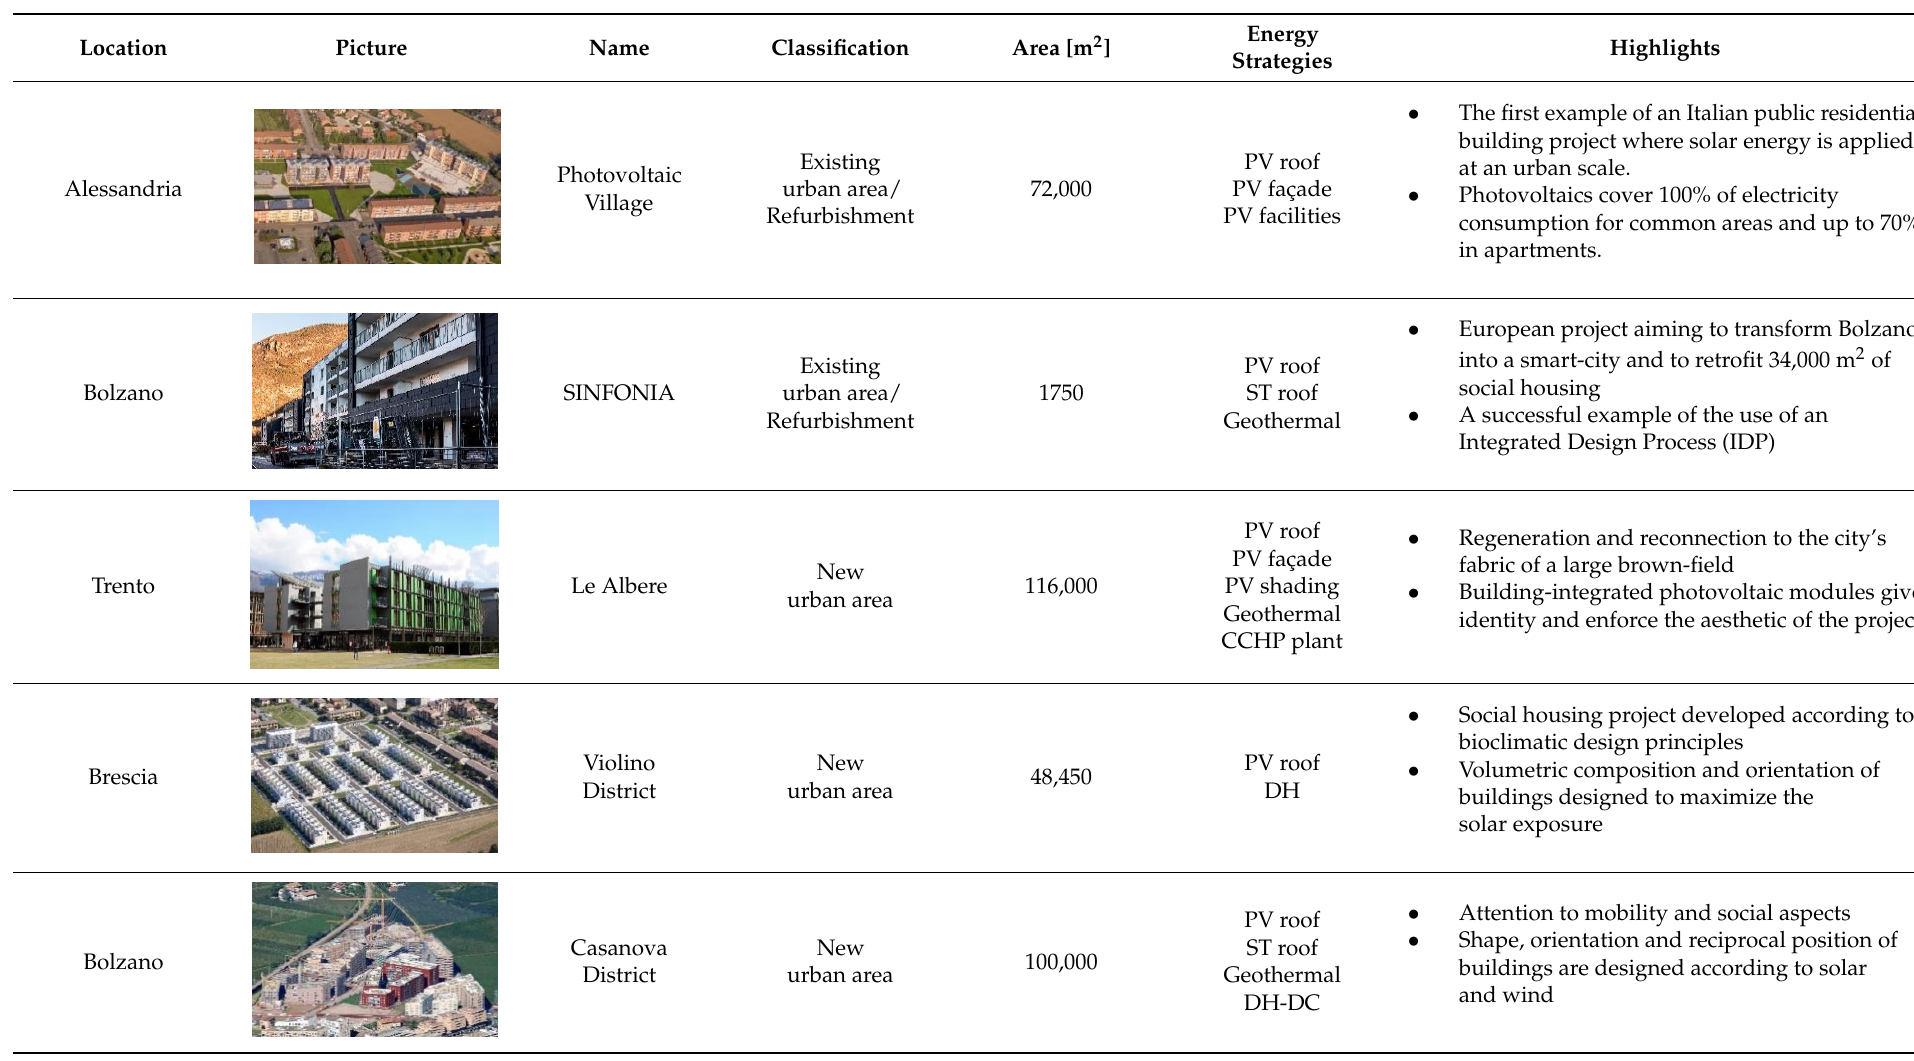
Table 2. Overview of the analyzed case studies. (CCHP: Combined Heating and Cooling; DH: District Heating; DC: District Cooling).